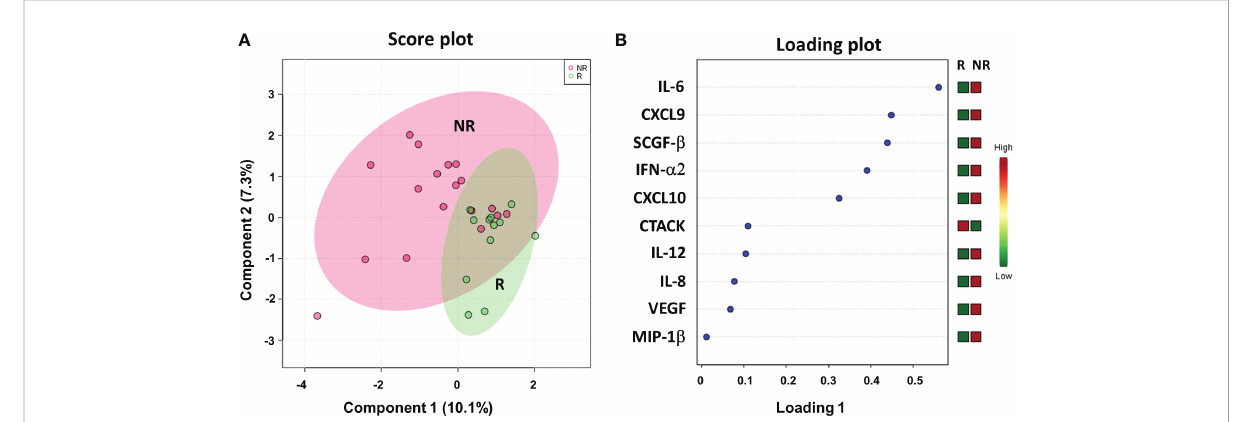
FIGURE 8 Score plot (A) and loading plot (B) related to cytokinomics pro fi ling on of mCRC patients, collected at response evaluation when liver resectability was established and subdivided accordingly to DFS in good (R; DFS ≥ 1 year) and bad (NR; DFS < 1 year)